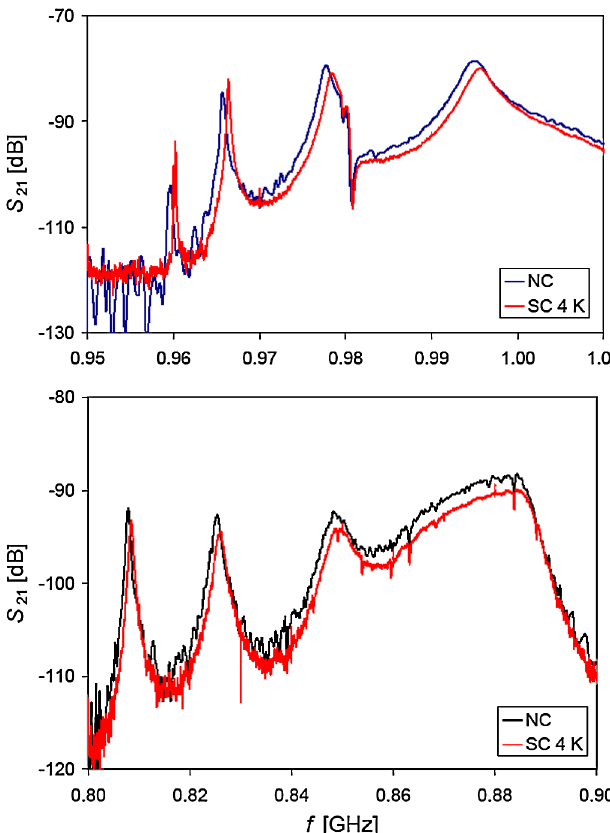
FIG. 6. Spectra of HOMs of the ERL five-cell cavity in the normal conducting (NC) and in the superconducting state (at 4 K).